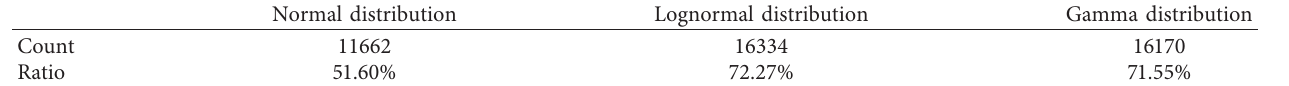
Table 3: The KS test statistical result of waiting time distribution in different